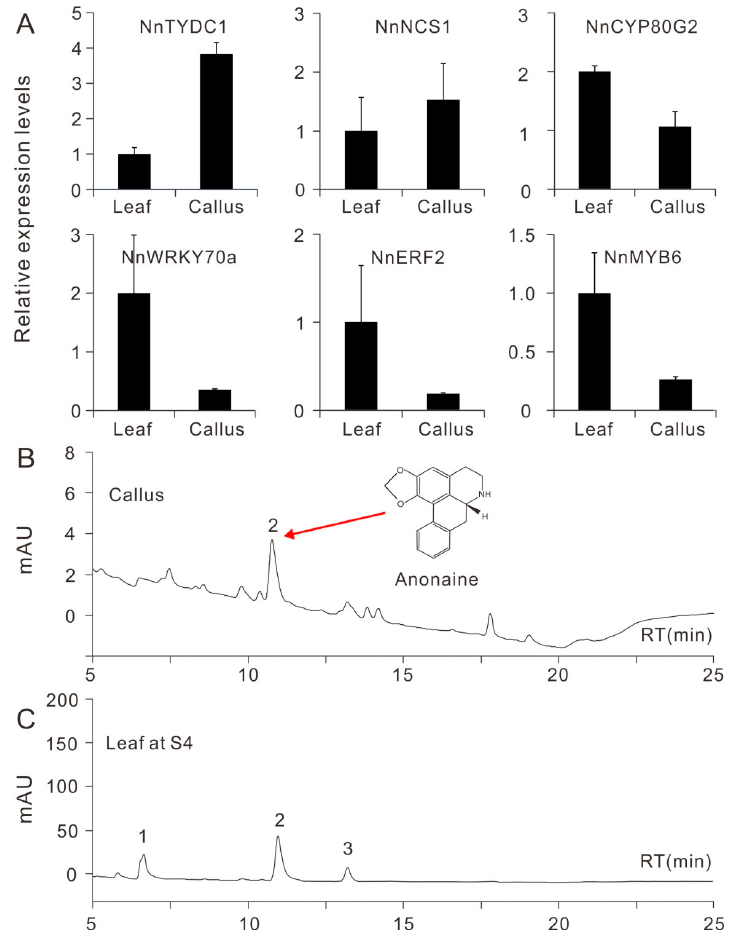
Figure 5. Relative expression of genes involved in benzylisoquilonine alkaloid (BIA) biosynthesis and the accumulation of BIA in lotus callus of the genotype “WBG_S1.” ( A ) Expression of three BIA biosynthetic genes and three transcription factors putatively involved in BIA biosynthesis. Data are means ± SE ( n = 3). ( B , C ) HPLC measurements of BIA components and concentration in lotus callus and leaves at the developmental stage 4, respectively. Peaks 1–3 represent N -nornuciferine, anonaine and nuciferine respectively.